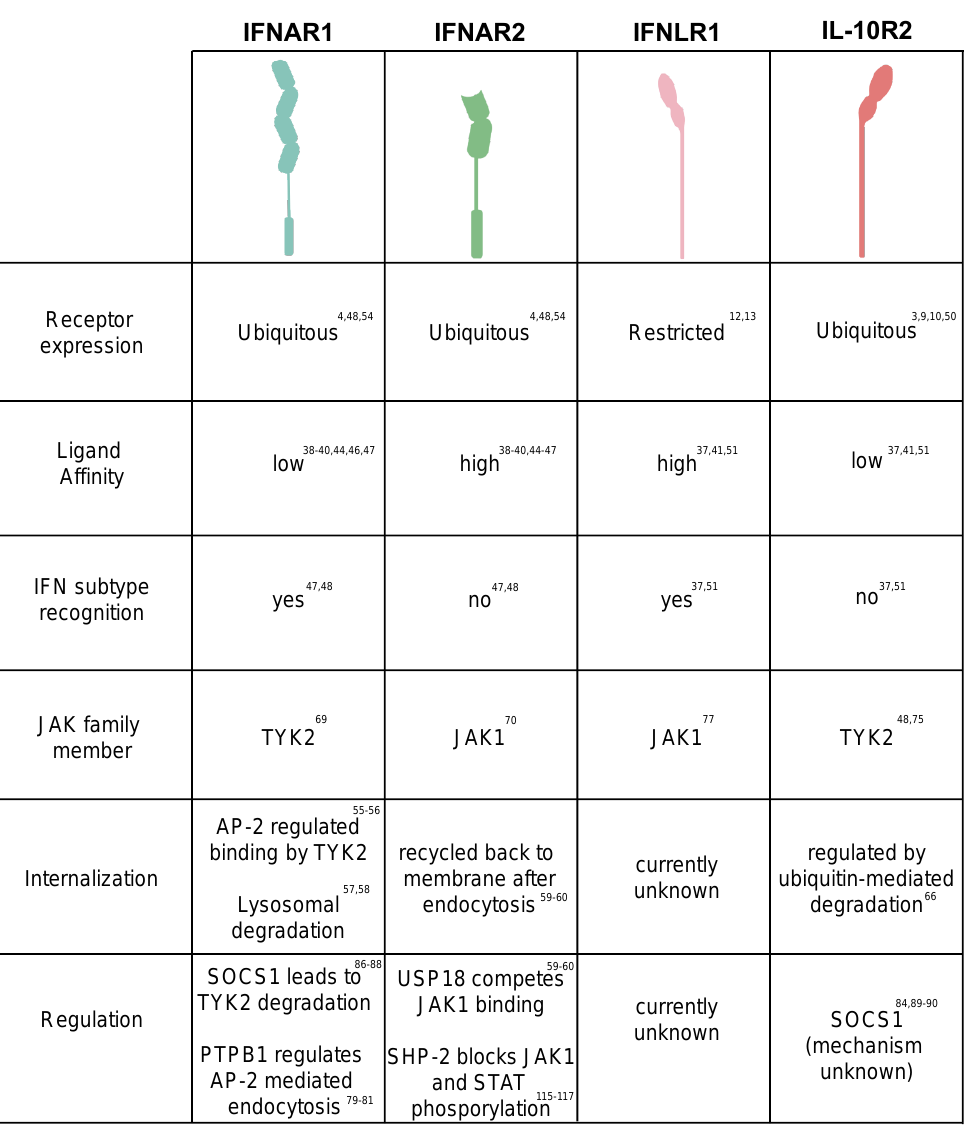
Figure 2. Regulation of interferon-mediated receptor signaling. Table summarizing the current state of the knowledge of both interferon receptor tropism, binding affinity for interferons, internalization/recycling mechanism and their known